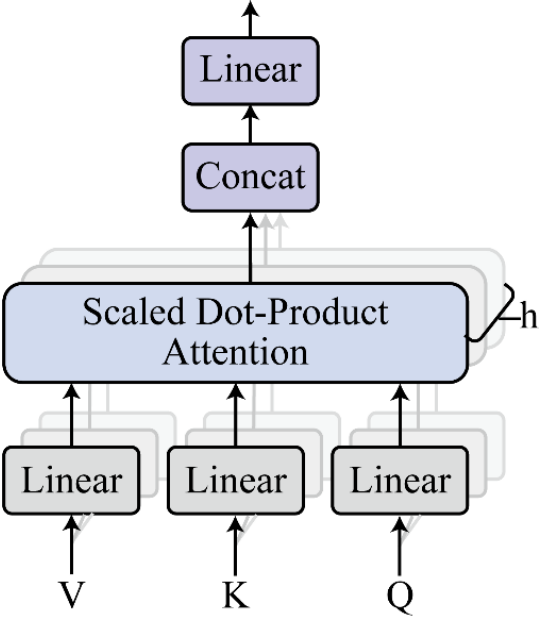
Figure 3. Graph multi-head attention. ( l ) ( l ) For each head attention, the source feature h and distant feature h are transformed i j ( l ) ( l ) into query vector q and key vector k , respectively. In this study, we transformed and c , i c , j propagated the features of each layer of nodes to obtain the node feature information data of the next layer. After the graph multi-head attention, the information aggregation